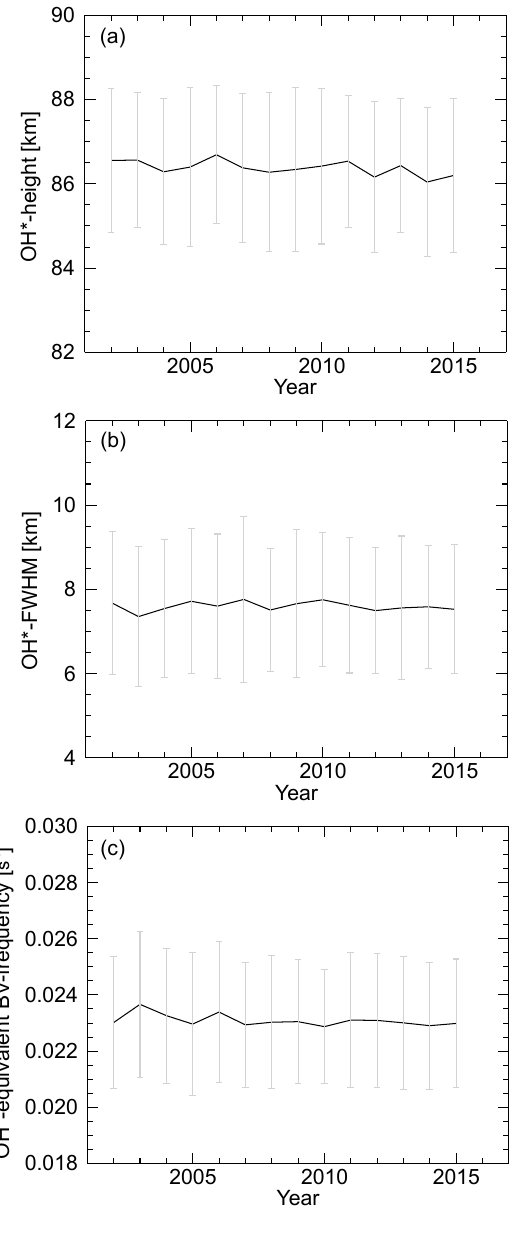
Figure 1. The yearly means of the height of the maximal OH- VER (denoted as OH* height, see a ), the FWHM (b) , and the OH*-equivalent BV frequency (c) are nearly constant from 2002 to 2015 (black curve) but show comparatively large standard devia- tions (grey bars) for each